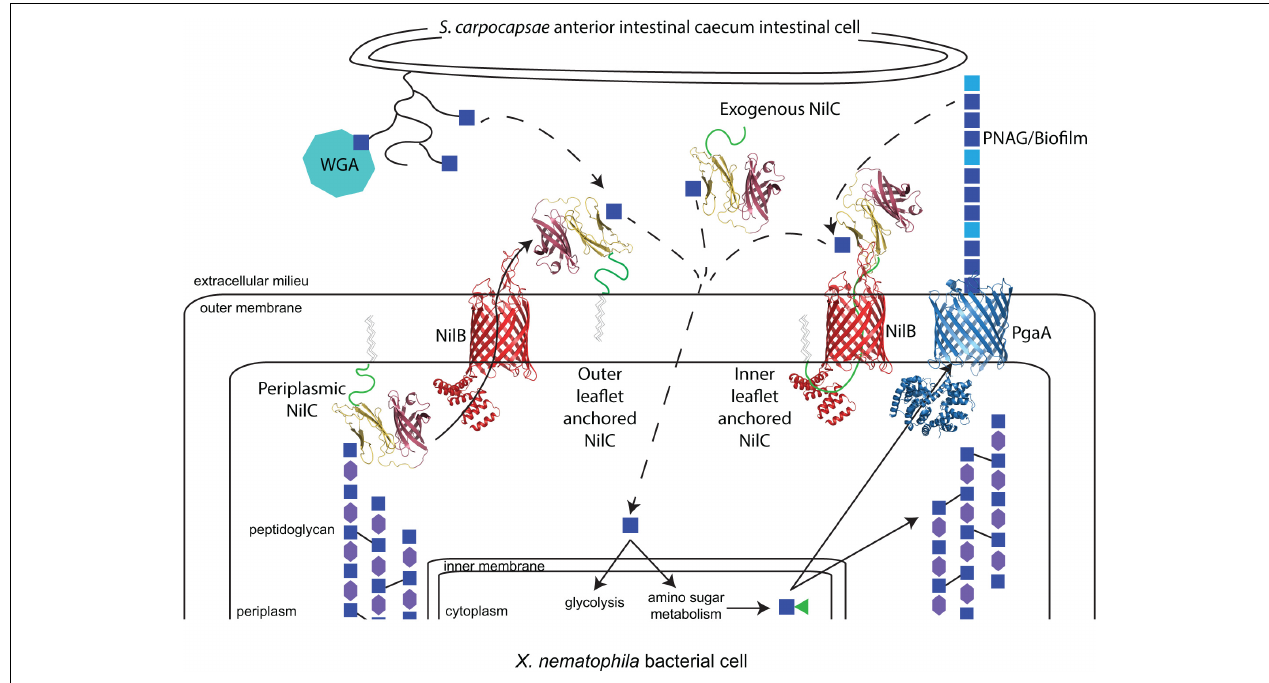
FIGURE 9 | The model of potential molecular interactions occurring during X. nematophila colonization of S. carpocapsae anterior intestinal cecum epithelial cell surfaces. N -acetyl-glucosamine (GlcNAc; blue squares) is present on the S. carpocapsae epithelial cell surface, possibly as part of mucin proteins (curved lines), as demonstrated by the binding of wheat germ agglutinin (WGA; teal octagon) to this tissue. GlcNAc is also a component of bacterial peptidoglycan, alternating in β -1,4 linkage with N -acetylmuramic acid (MurNAc; purple hexagons) and crosslinked to other polysaccharide chains through peptide linkages (black solid lines). X. nematophila encodes homologs of the Pga synthase-dependent exopolysaccharide secretion system for the production of poly- β -1,6- N -acetyl-glucosamine (PNAG), composed of GlcNAc and de-acetylated GlcN (light blue squares). A working model based on evidence presented in this study is that periplasm-oriented NilC binds through its N-terminal effector domain (yellow) to GlcNAc residues within peptidoglycan, possibly modulating turnover. NilC can be extracellular, and its transport across the outer membrane by NilB (red) is directed by virtue of its C-terminal β -barrel TXISS-targeting domain (purple). The lipid anchor of NilC may be embedded either in the inner or outer leaflet of the outer membrane. In the former possibility, the long, disordered N-terminal region of NilC (a green cartoon line) may thread through the barrel of NilB, analogous to the structural interactions between the lipoprotein RcsF and associated OMPs (Rodriguez-Alonso et al., 2020). Extracellular NilC may bind to nematode or bacterial glycan-derived GlcNAc and facilitate its uptake (dashed arrows). NilB (red) and NilC models are predictions from Phyre2.0 and AlphaFold, with the N-terminal random coil of NilC represented as a green cartoon line. The structure of PgaA (blue) is PDB 4Y25 (Wang et al.,